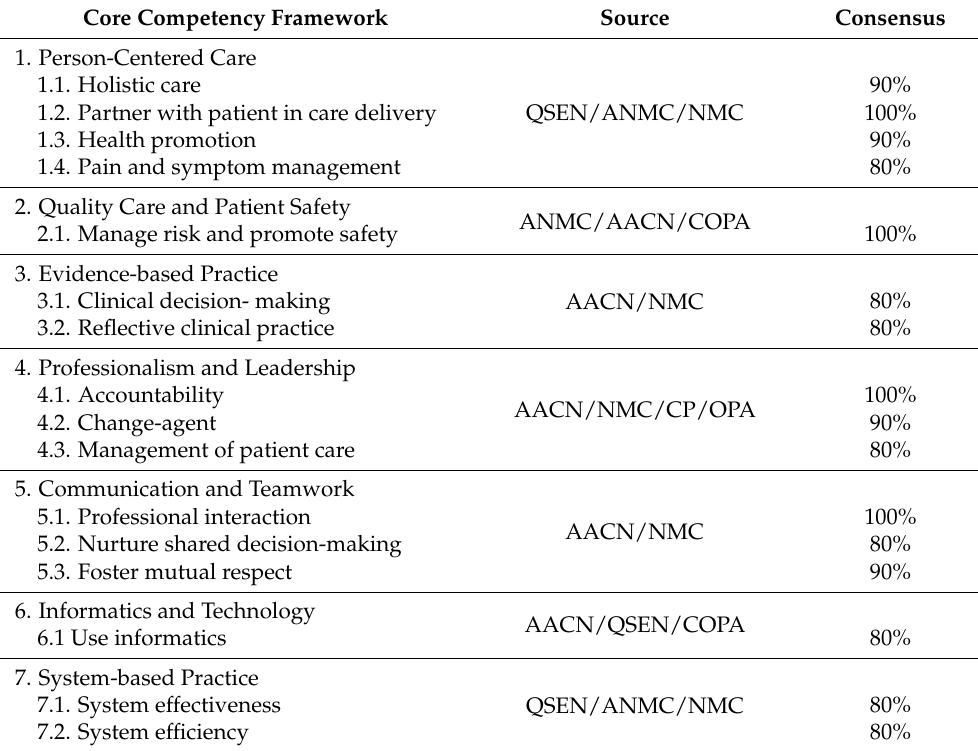
Table 3. Competency domains and competency elements after Round